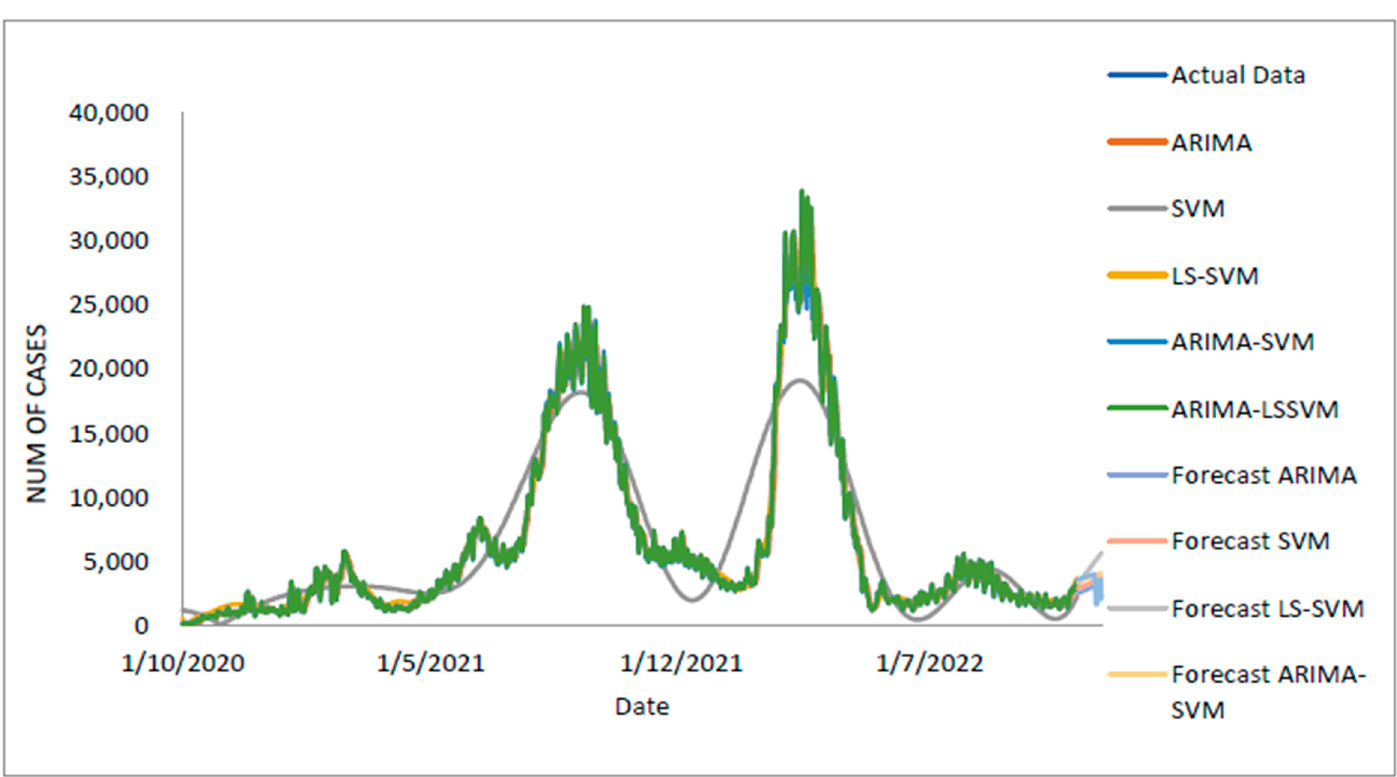
Figure 13. Actual and three weeks ahead forecasted values of ARIMA, SVM, LS–SVM, ARIMA–SVM and ARIMA–LSSVM models for daily new recovered COVID-19 cases of the 80% training and 20% testing set.